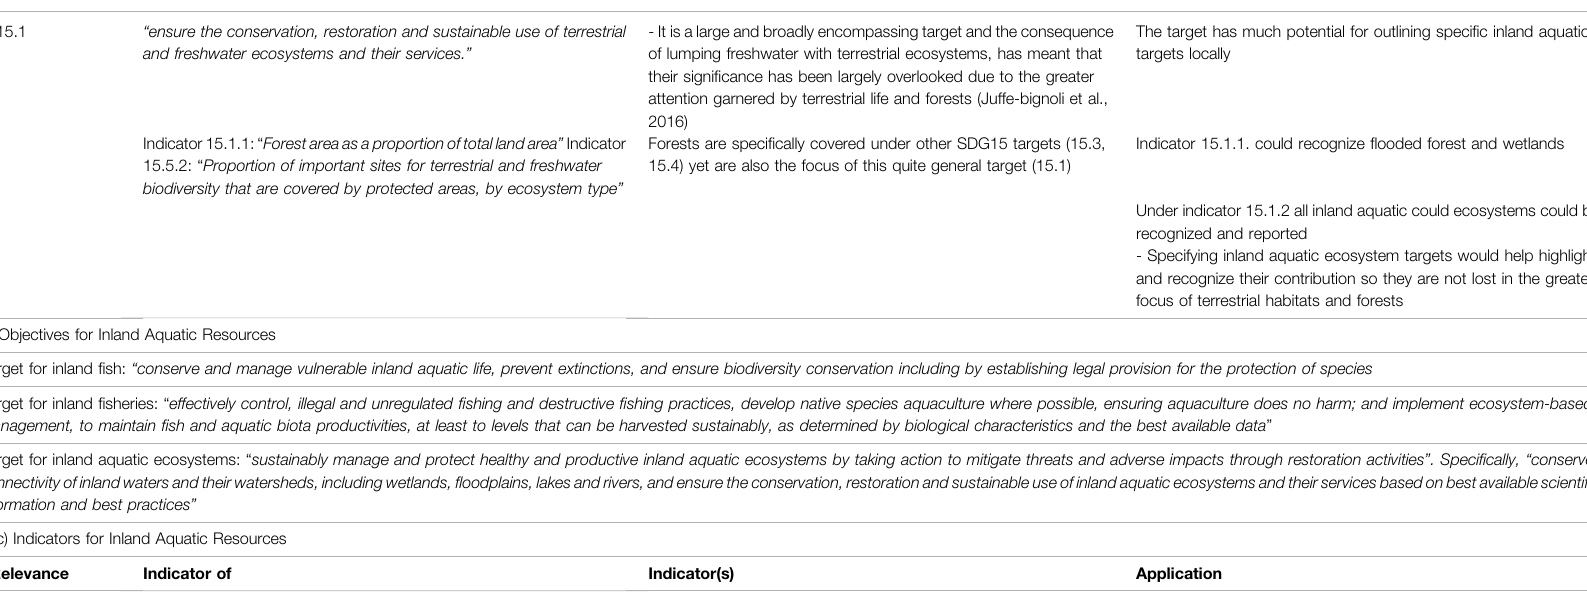
proportion of species identi fi ed as threatened for which appropriate protection is recognized in law, policy, or regulation monitored,regulated,andenforcedspatially,seasonally,bybiomass, species and according to size compromising ecological integrity, while maintaining social equity, ecological integrity and economic growth - the extent to which the Ecosystem Approach to Fisheries Management is being correctly applied and effectively adapted for national, regional, and local